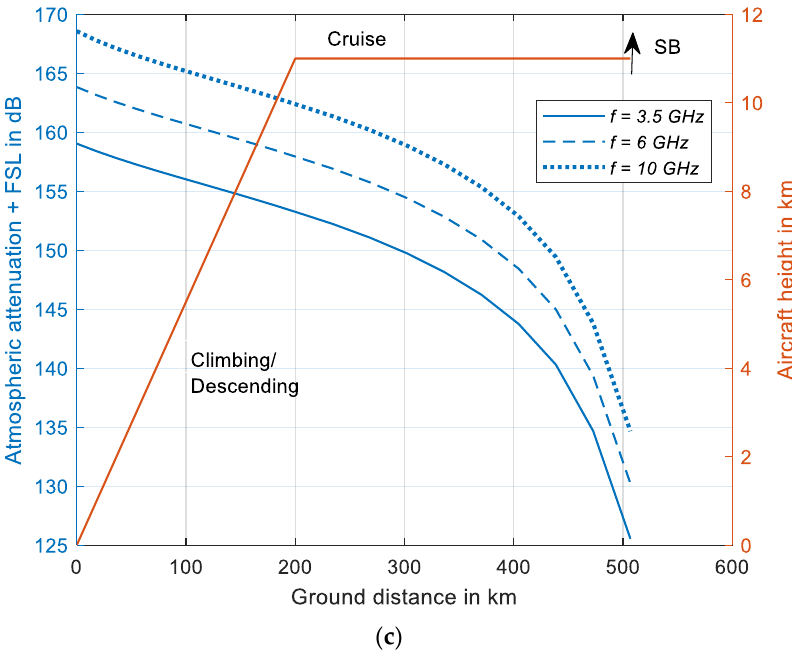
Figure 11. Flight signal attenuation performance for 5G frequencies up to 10 GHz in dB: ( a ) atmospheric gaseous attenuation, ( b ) free-space loss (FSL), ( c ) combined atmospheric gaseous attenuation and FSL performance.